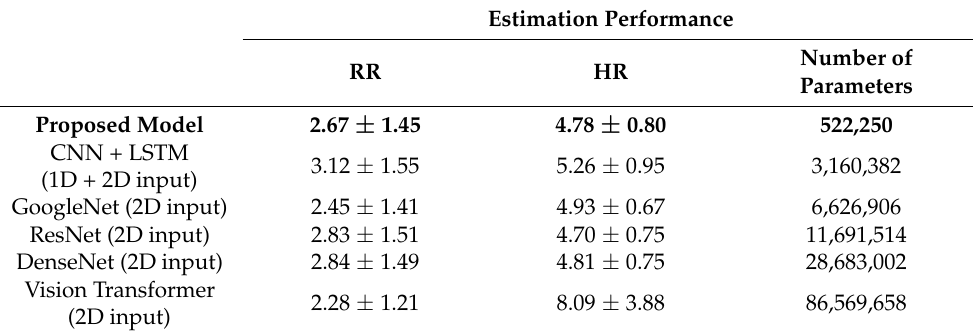
Table 5. Vital-sign detection performance using the proposed model and pretrained models on the test dataset. (mean ± STD of